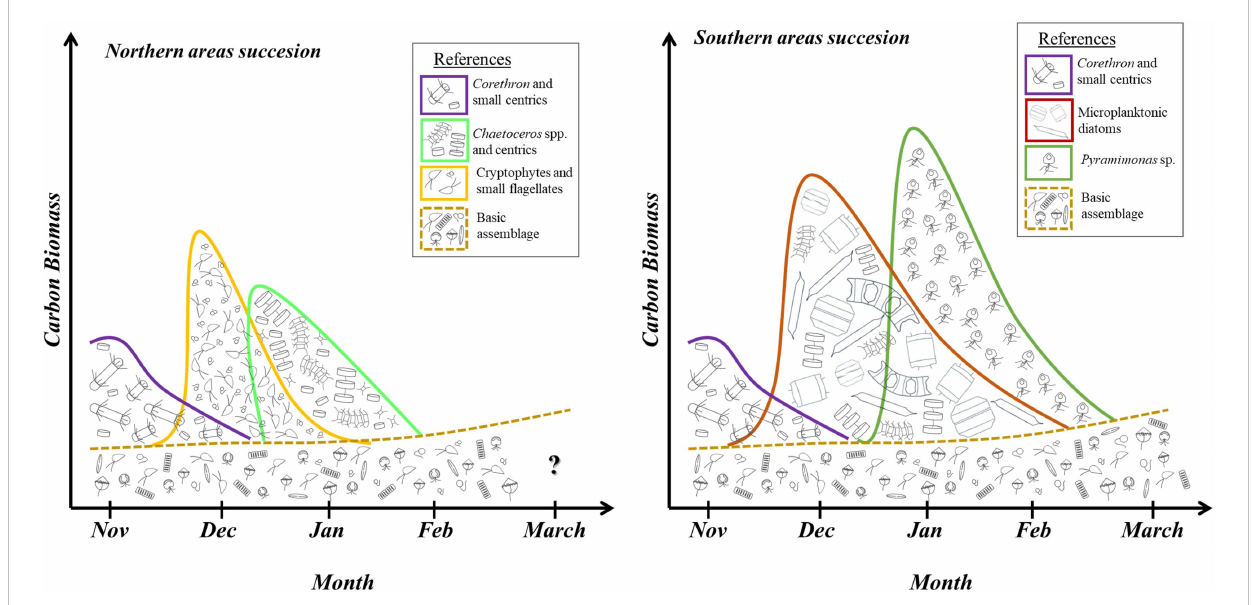
FIGURE 7 Conceptual model diagram illustrating the phytoplankton summer succession from November to March in northern and southern areas of the Gerlache Strait during seasons 1 and 2, constructed from the average of the biomass data found in the northern and southern areas for each season. The main assemblages described here are: 1) an assemblage composed of Corethron pennatum and small centric diatoms < 15 µm (in violet); 2) an assemblage of medium-size centric diatoms between 20 and 60 µm (e.g. Actinocyclus actinochilus , Thalassiosira spp., Porosira spp.) and Chaetoceros spp (in light green); 3) an assemblage dominated by cryptophytes and small fl agellates (in orange); 4) a basic assemblage composed by small unidenti fi ed fl agellates, cryptophytes, small naked dino fl agellates, small prasinophytes, haptophytes, and small fragilarioid and naviculoid diatoms (in brown); 5) an assemblage composed of large microplanktonic diatoms (e.g. Odontella weiss fl ogii ; Proboscia spp., Eucampia antarctica , Coscinodiscus bouvet ) (in red); 6) an assemblage dominated by prasinophytes from the genus Pyramimonas (in